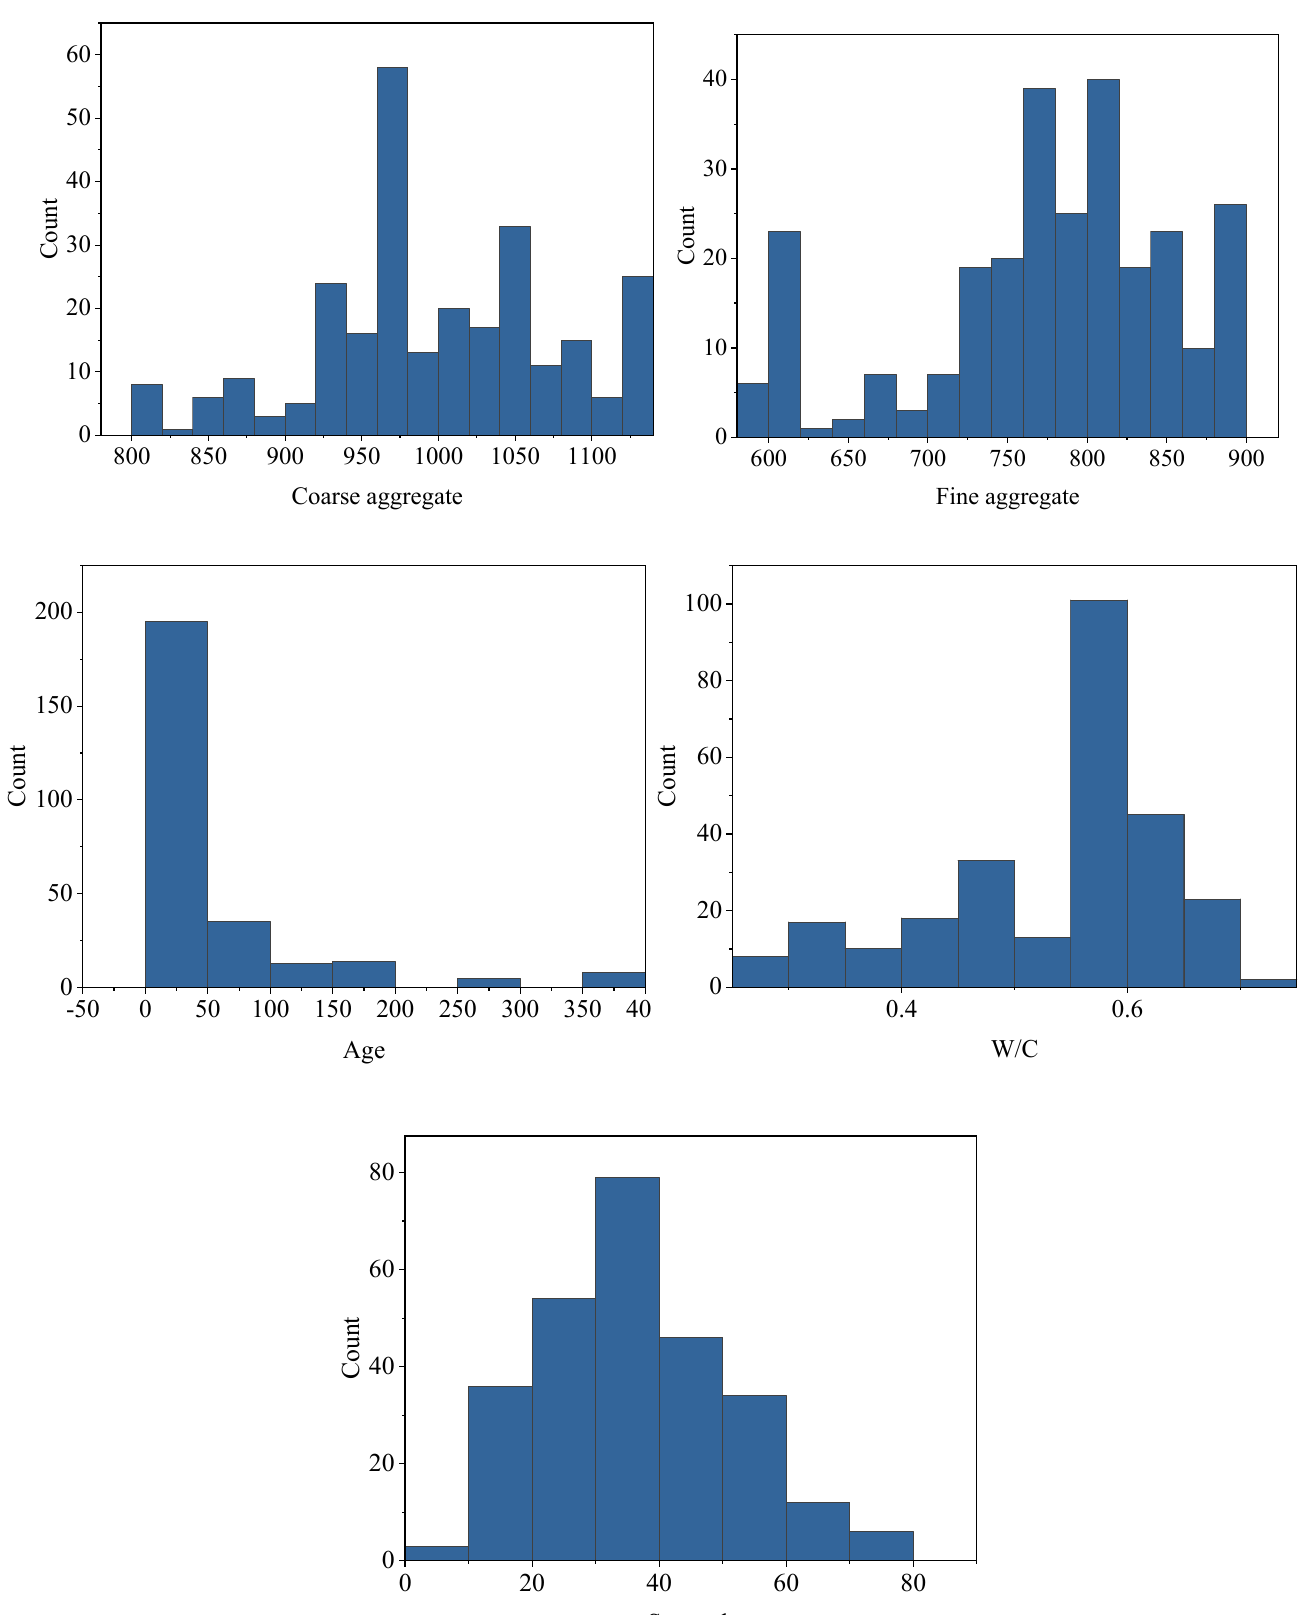
Figure 4. Histograms of the input and output variables.